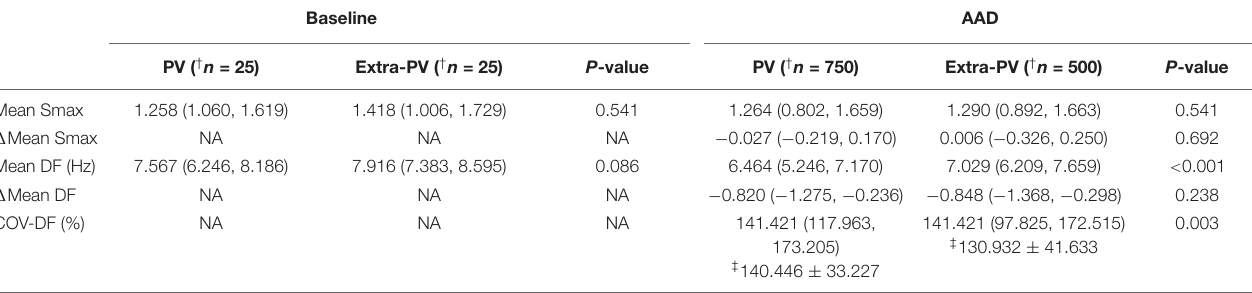
TABLE 2 | Effects of antiarrhythmic drugs (AADs) on the pulmonary vein (PV) vs. Extra-PV tissue.